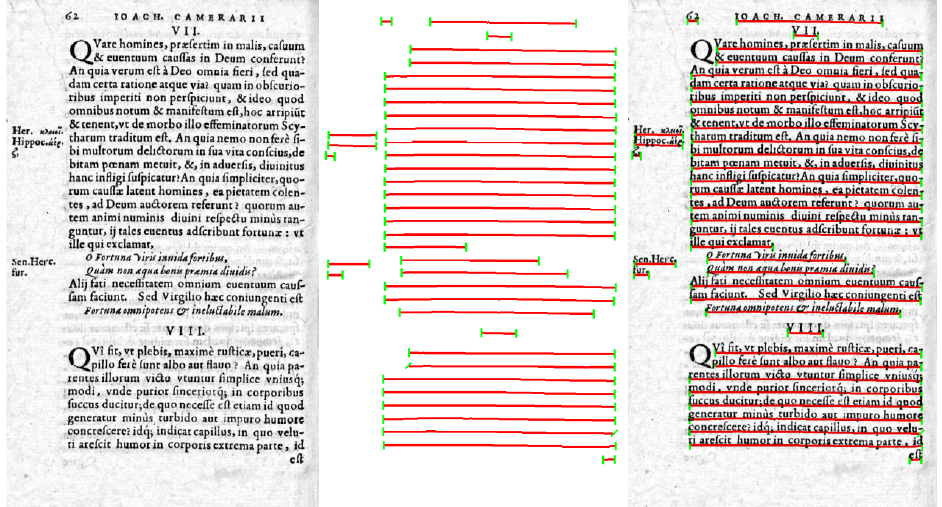
Figure 4. Example of the masks used as the GT for training the U-Net. On the left is the original image, in the middle the mask, and on the right a visualization of the mask overlaying the original. Green marks symbolize left and right text borders; red marks symbolize the baseline of the text